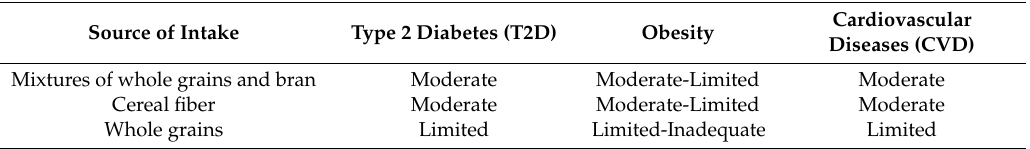
Table 7. Level of evidence between whole grains and bran intake and health benefits (adapted from Cho et al. (2013)